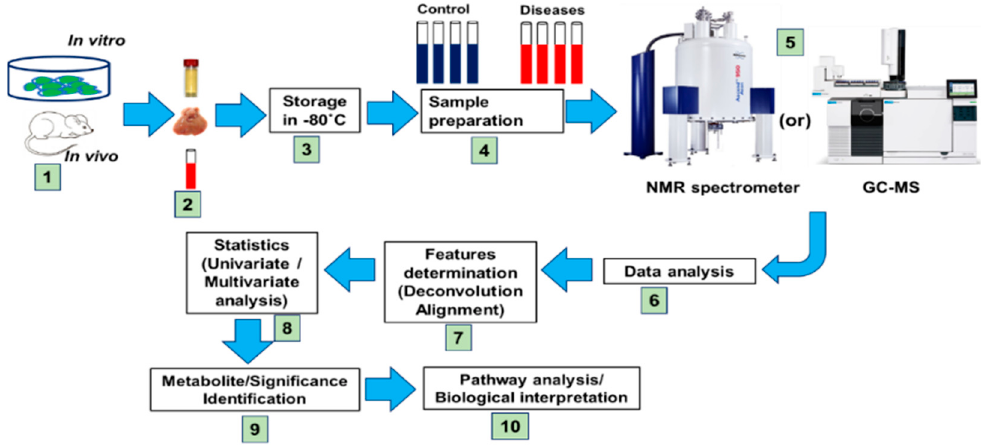
Figure 3. Proposed structure of symmetrical metabolomics experimental design for evaluating storage and quantitative metabolite analysis. Types of sample assessment: sample collections in tubes, data processing, statistics, and metabolic pathway analysis. The robotic high throughput metabolomics technique in liver and gut microbial/organic mixtures reveals their spectral complexity and their metabolic significance.